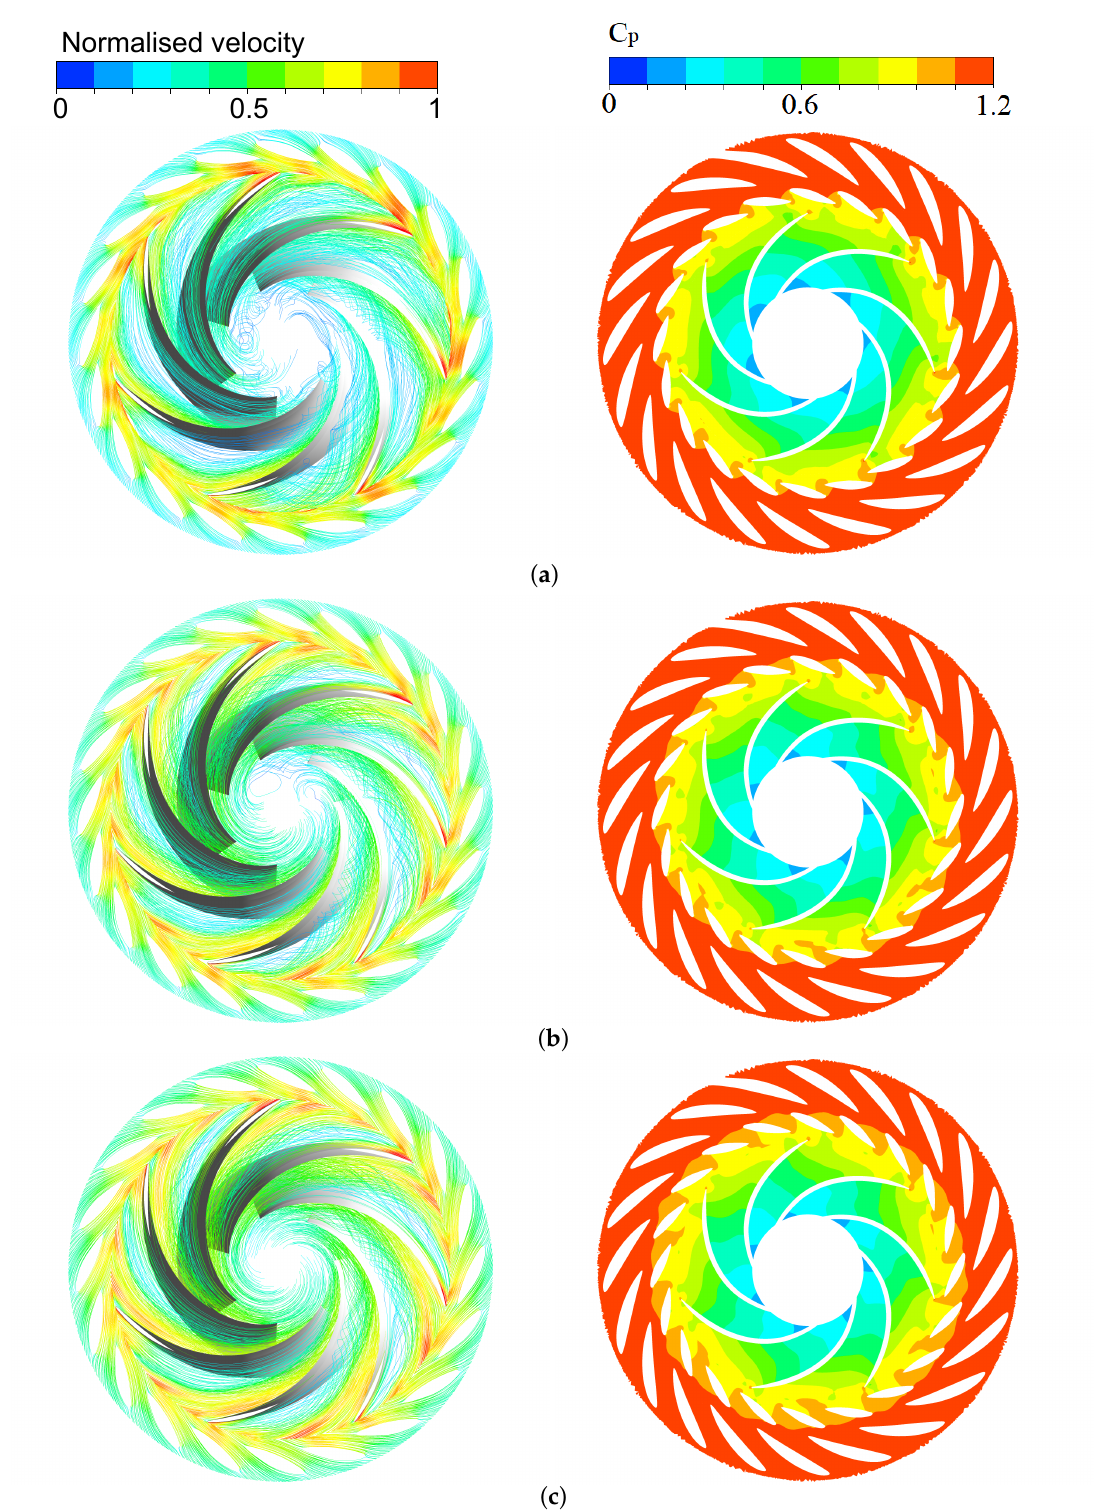
Figure 10. Velocity and pressure distributions in the middle section of the turbine flow channel under different loads in turbine mode. ( a ) 60% load condition. ( b ) 86.7% load condition. ( c ) 100% load condition. The pressure coefficient C p is defined